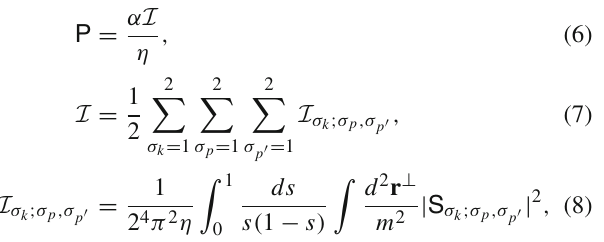
parameter η = κ · k / m 2 and the number of laser